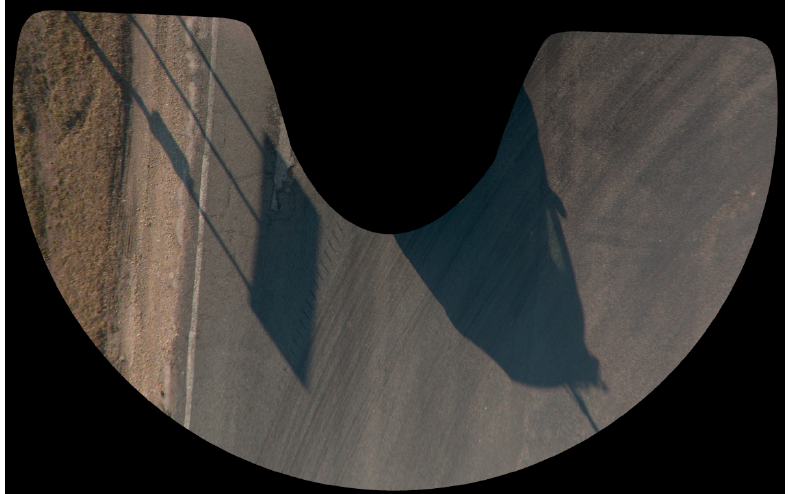
Figure 3. Shadows in the orthoframe cast by roadside objects and the vehicle